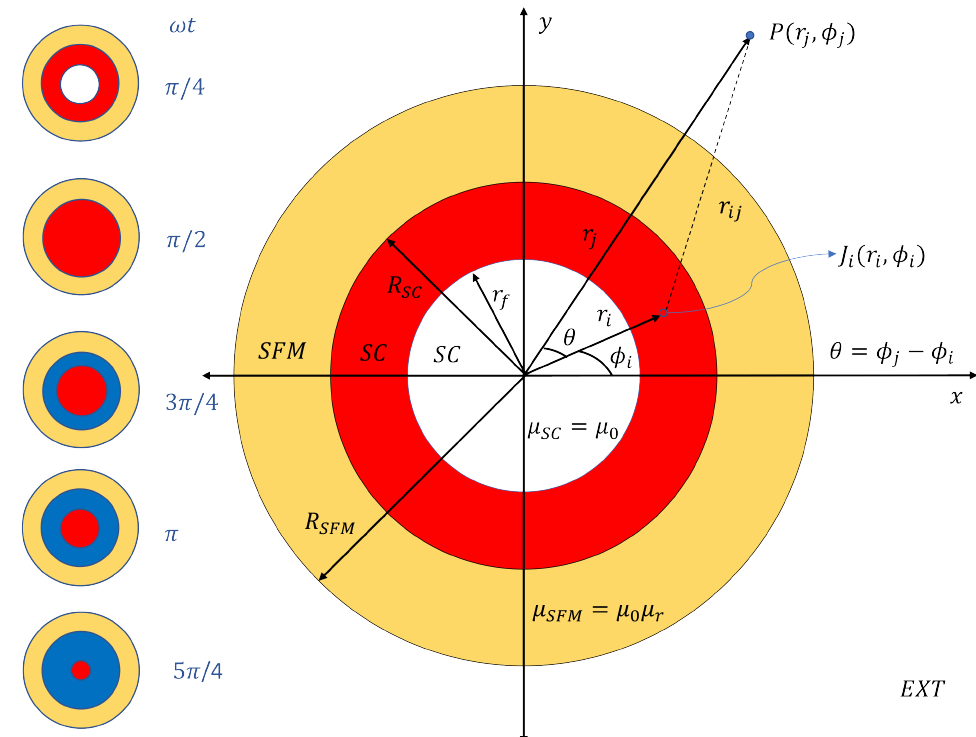
Figure 1. Pictorial representation of the analysed Superconducting (SC) Soft-Ferromagnetic (SFM) metastructure. The main plot shows the distribution of current density, J , in the SC under self-field conditions for an applied transport current I tr = I c sin ( ω t ) , with ω t = π /4 (red shadowed area), and the relative coordinates for a finite-element J i ( r i , φ i ) as a reference for Equations (5)–(18). The left-plots show, for illustration, the time dynamics of the superconducting current density J within the SC-SFM metastructure. Red and blue areas correspond to distributions with J i = ± J c ˆ u z , respectively. White areas correspond to regions with no J , and the yellow area corresponds to the SFM sheath where no I tr is to